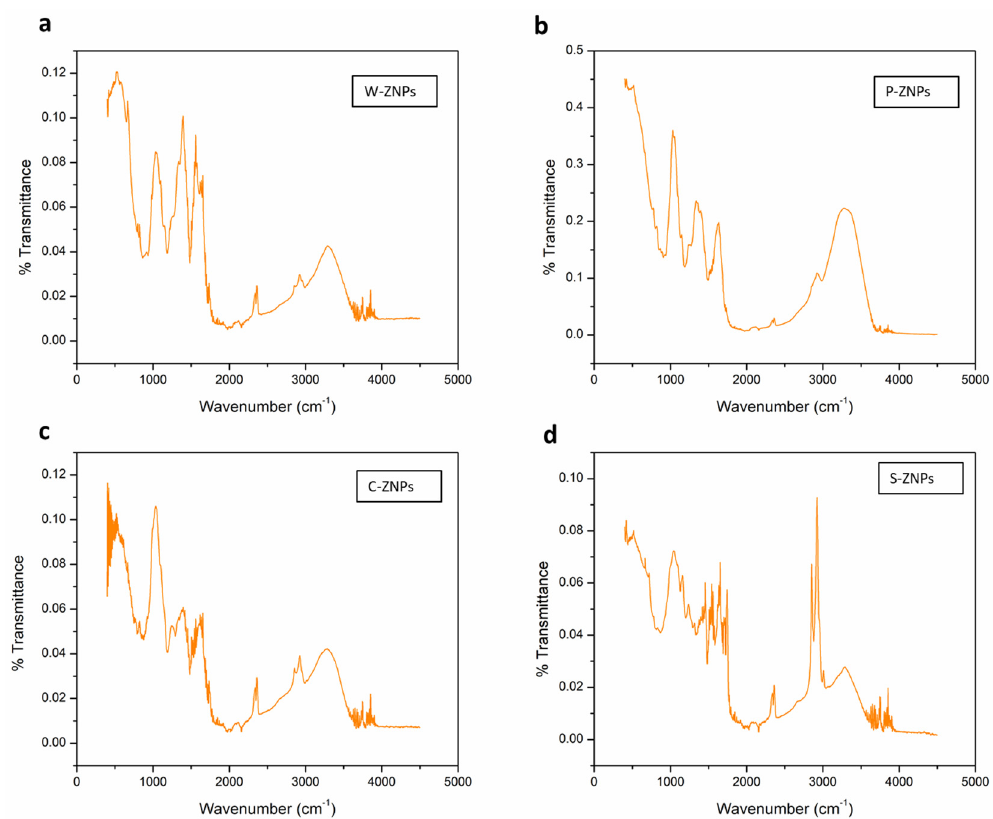
Figure 3. FTIR spectral analysis of ( a ) W-ZNPs, ( b ) P-ZNPs, ( c ) C-ZNPs and ( d ) S-ZNPs.